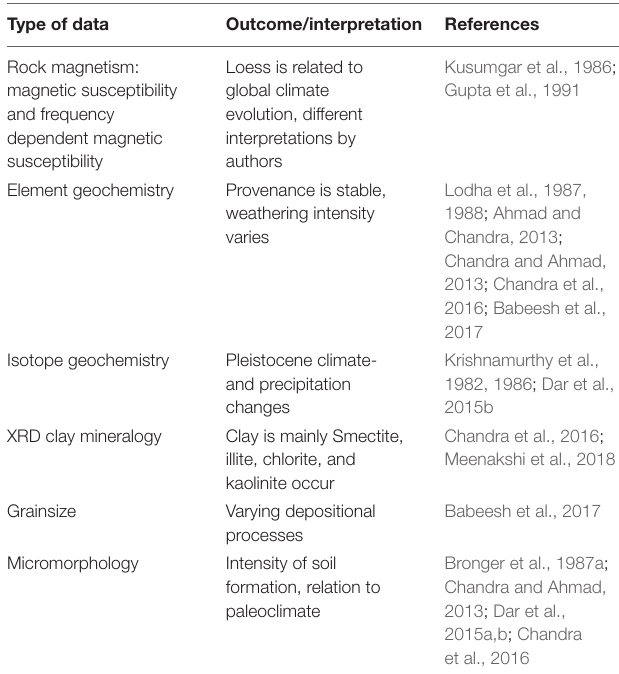
TABLE 2 | Summary of physical- and chemical studies on Kashmir